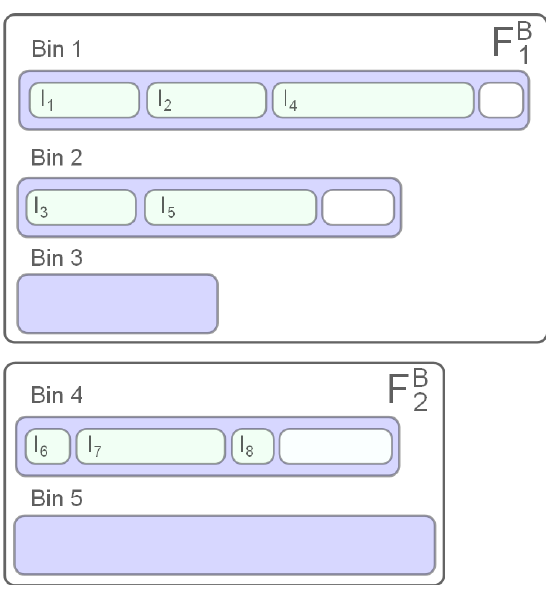
Figure 3. Item and bin groups. Acceptable solution: F I